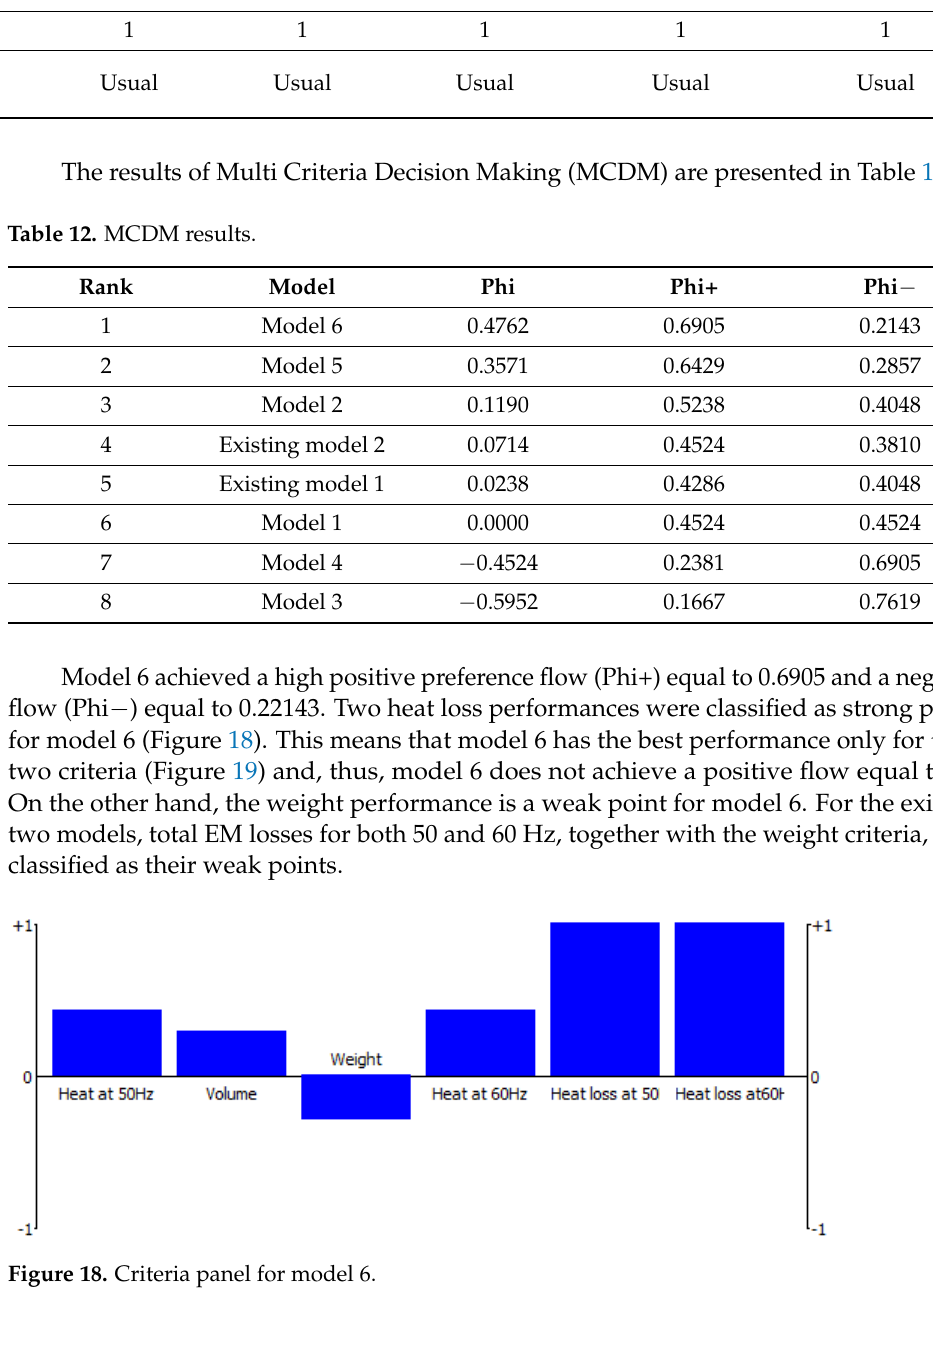
Table 11. Data for conduction of numerical experiments.